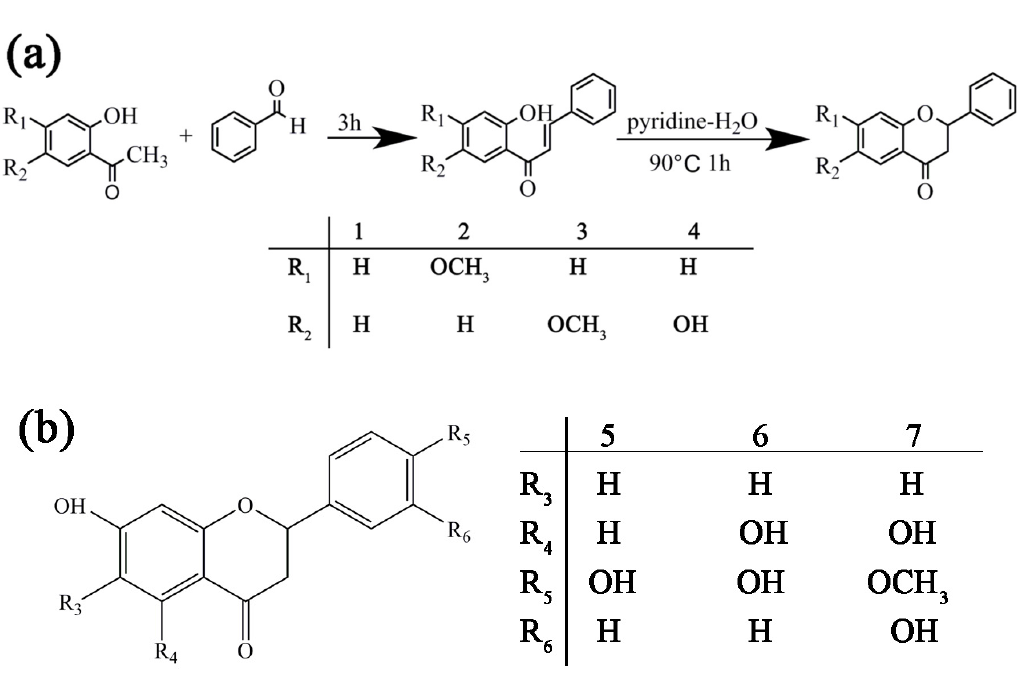
Figure 10. ( a ) The reaction route of flavanone derivatives 1 – 4 . ( b ) Chemical structure of